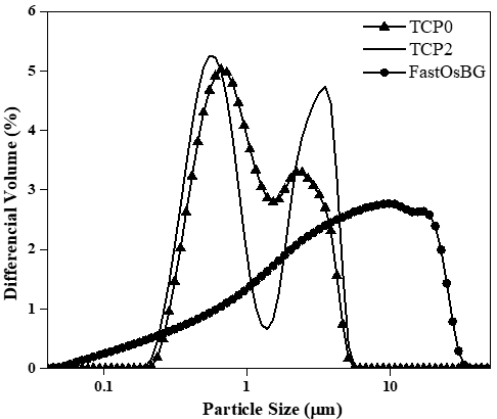
Figure 3. Particle size distributions of the starting TCP0, TCP2 and FastOS ® BG powders after ball milling.